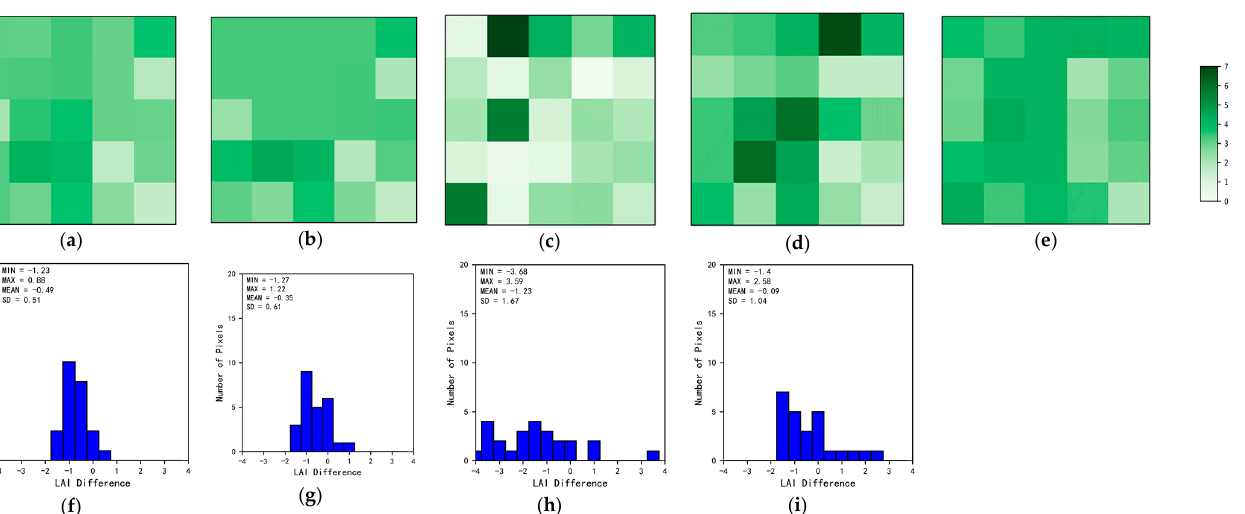
( i ) Figure 8. Images of the LAI-TCA ( a ), the LAI-GRNN ( b ), the VIIRS ( c ), the MODIS ( d ) and the LAI values acquired from high-resolution reference maps ( e ) at the Capitanata site on Day 113, 2015. ( f –